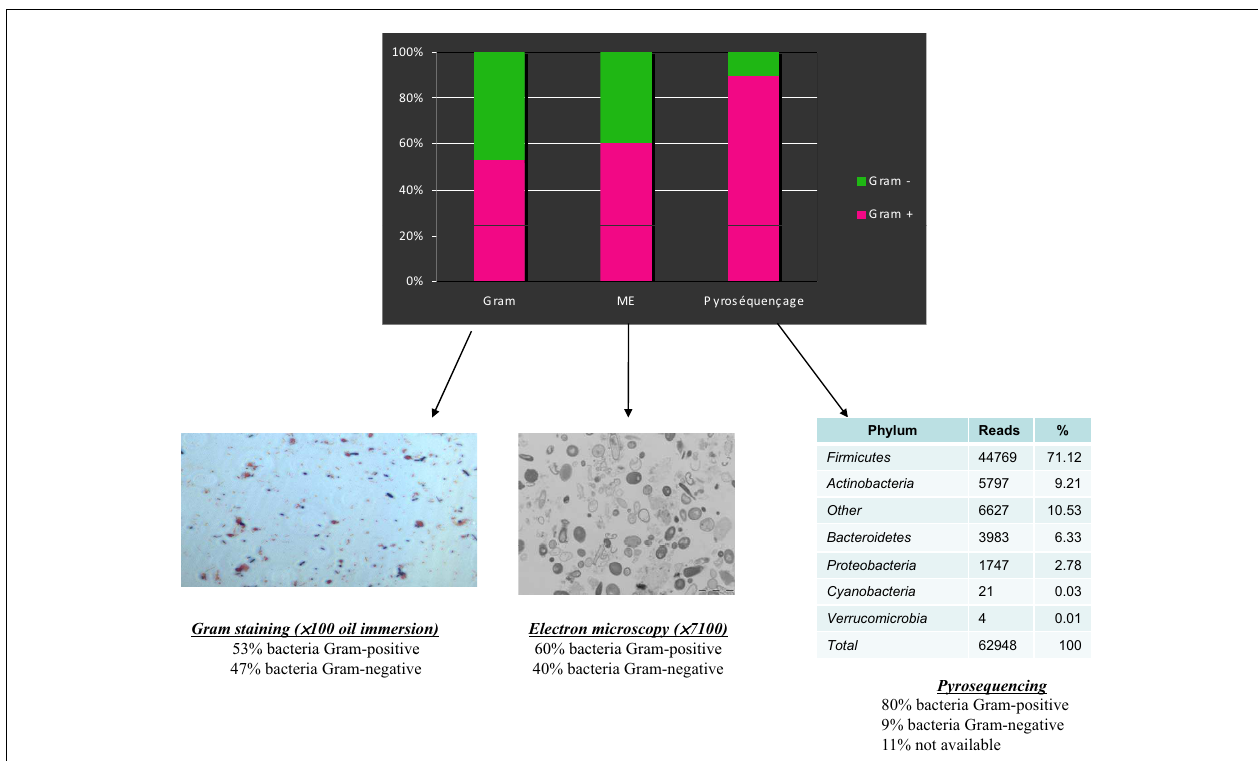
FIGURE 2 |A comparison of Gram staining, electron microscopy, and pyrosequencing to determine the proportion of Gram-positive/Gram-negative bacteria in the same stool sample (personal data).